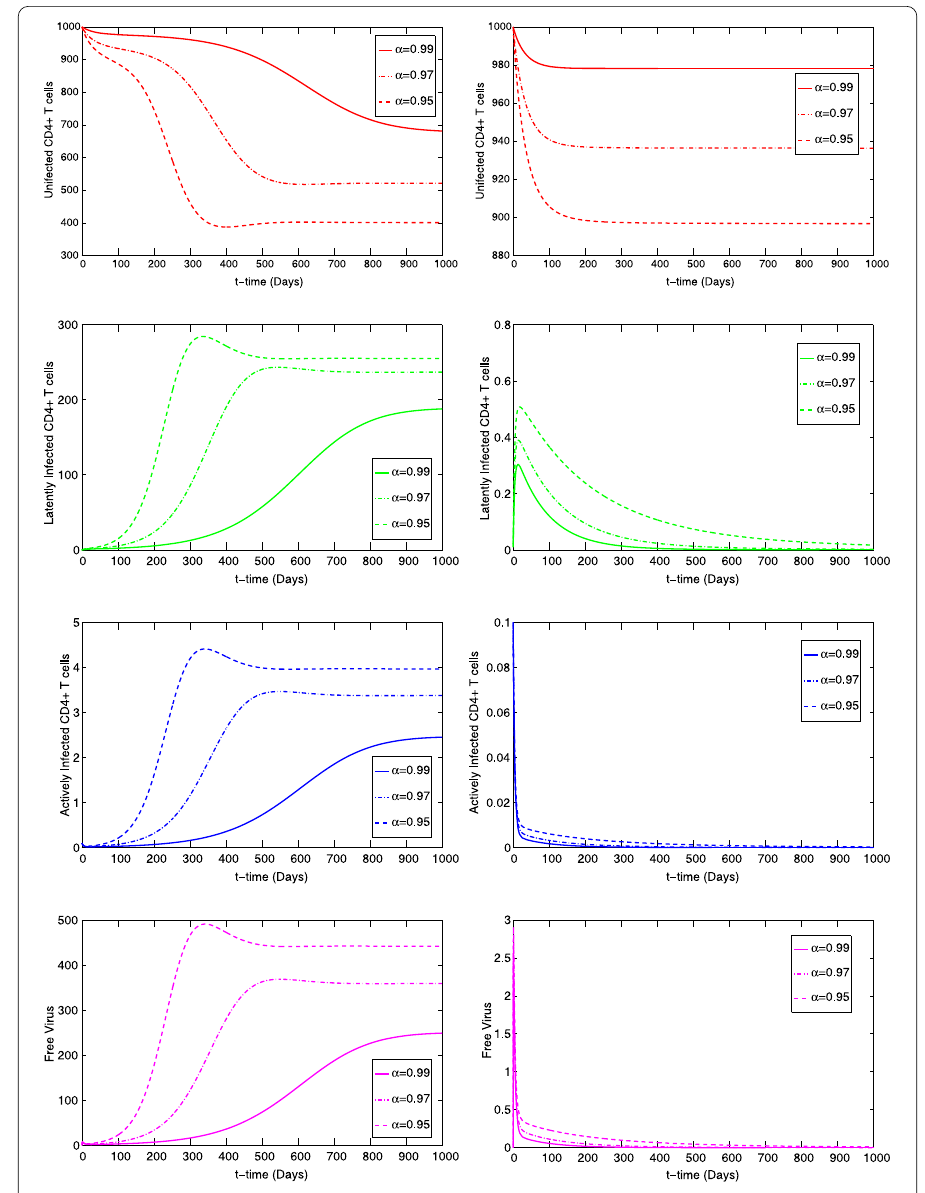
Figure 2 Solution of fractional HIV model with μ α α = 0.99,0.97,0.95. Take N = 1,000 with initial condition ( T 0 , T 0